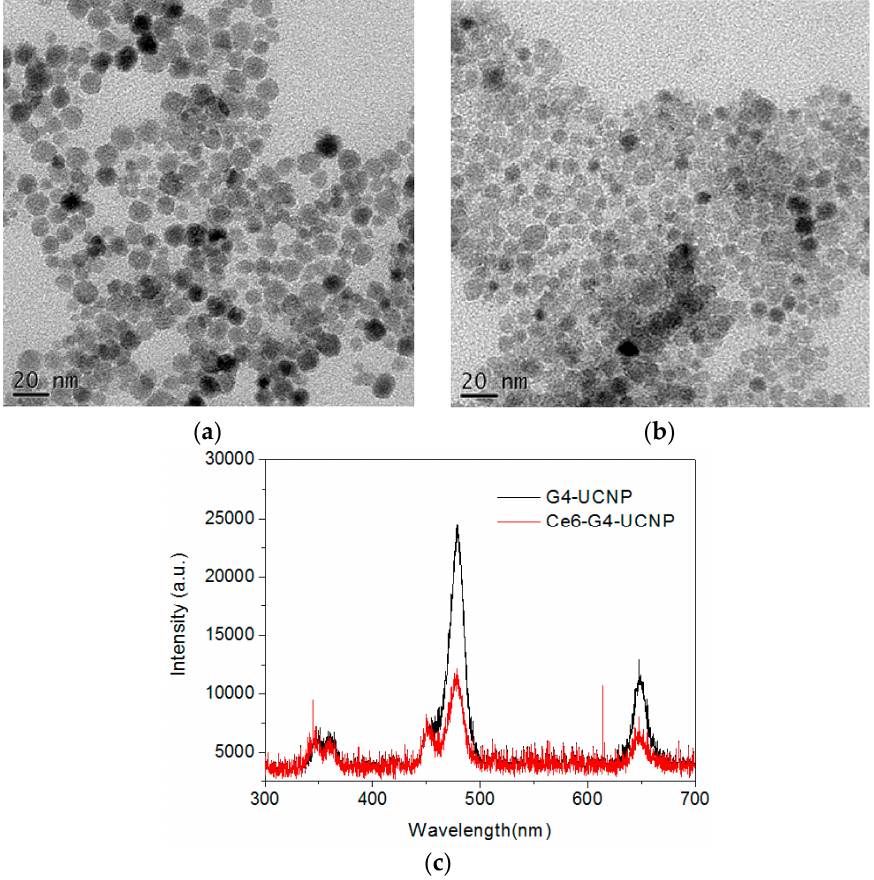
Figure 2. Transmittance electron microscopic (TEM) images of: ( a ) citrate; and ( b ) PAMAM dendrimer-encapsulated nanoparticles (G4-UCNP). ( c ) Upconversion fluorescence of G4-UCNP in water under 980-nm laser excitation. The fluorescence intensity was extinguished after encapsulation of Ce6 (Ce6-G4-UCNP).